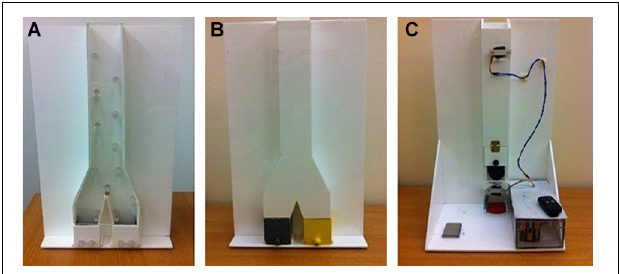
FIGURE 1 | Transparent training box (A) , opaque testing box (B), and the back of the opaque testing box (C) used in Experiments 1 and 3.